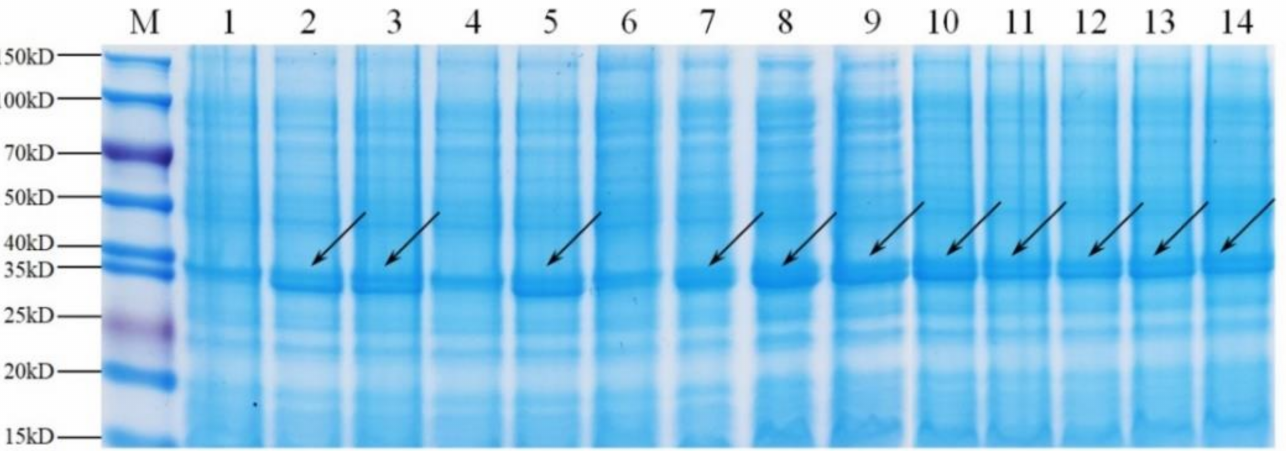
Figure 2. Expression and identification of PelG403 and mutants. M: protein marker; 1: pET28a (negative control); 2: PelG403; 3: A41V; 4: A82V; 5: A129G; 6: A129P; 7: A129V; 8: A112P; 9: A112V; 10: A160V; 11: A201P; 12: A201G; 13: D333E; 14: D341E.